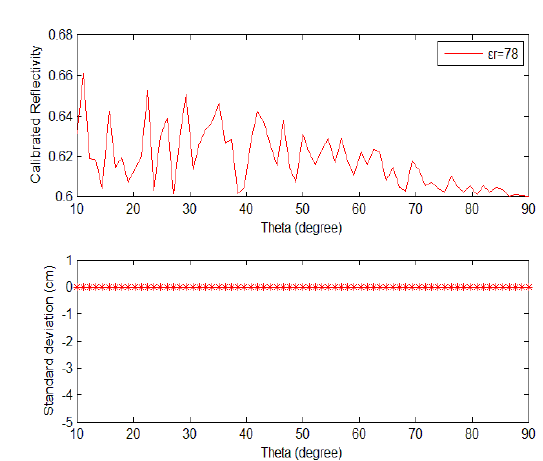
Fig. 3. The estimation of soil surface roughness for random surface (lake).